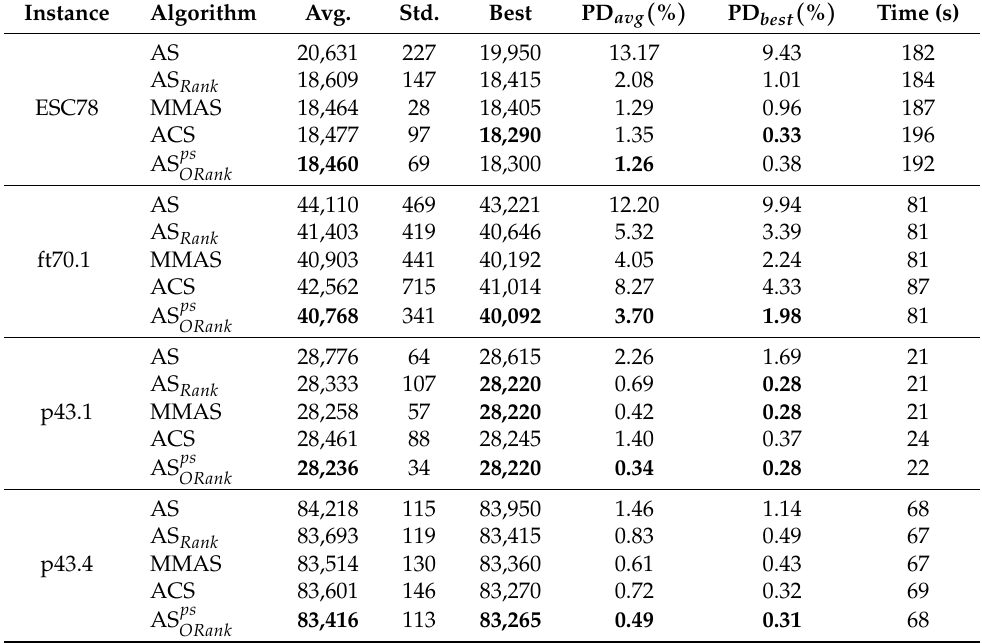
Table 6. Results for SOP instances obtained by ACO algorithms. The best results for each problem instance are highlighted in